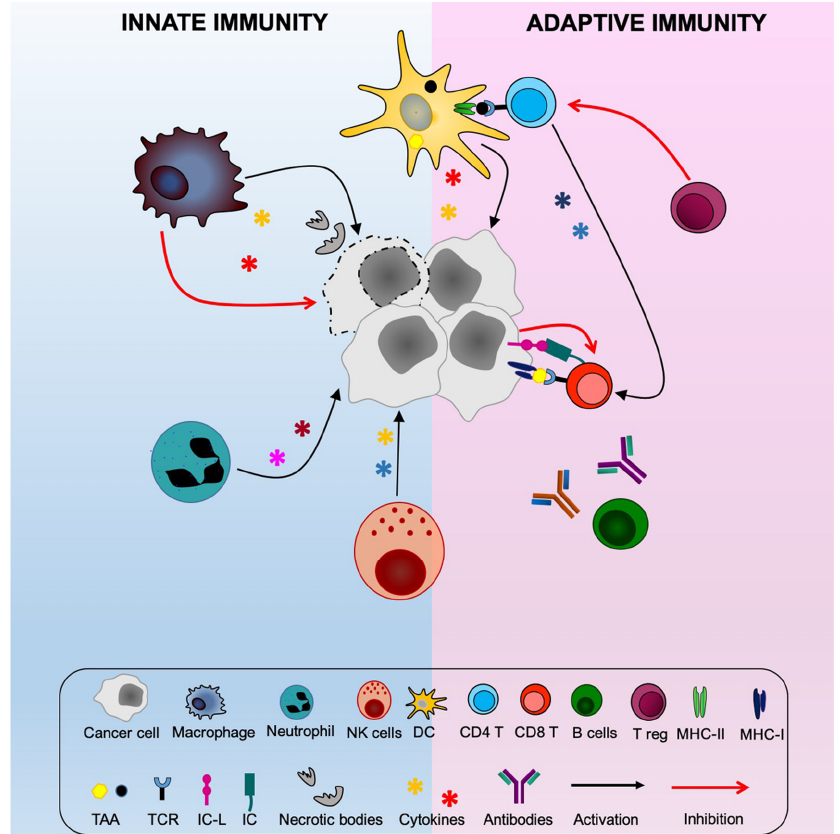
Figure A1. The basic elements of anti-tumor immunity. Cells of the innate immunity such as macrophages and neutrophils, attracted at the tumor site, participate to the destruction and engulphment of the tumor cells via secretion of several products such as inflammatory cytokines (black arrows). Tumor cells may polarize the phenotype of macrophages toward a pro-tumor phenotype (red arrows) by modifying their production of inflammatory cytokines in anti-inflammatory cytokines. At the edge of innate and adaptive immunity, NK cells participate to the host immune response by killing tumor cells that have lost MHC class I expression to elude adaptive CTL immunity. Dendritic cells engulphing necrotic tumor cell debris process and present tumor antigens via their MHC class II molecules to CD4 + Th cells which then trigger the e ff ector mechanisms of anti-tumor immunity, such as antibody producing B cells and particularly CD8 + CTL (black arrows), by secreting specific cytokines. CD4 + Th activity can be blocked by regulatory T cells (Treg), thus hampering the activation of downstream CTL. Moreover, tumor cells can directly block the action of CTL by expressing immune checkpoints ligands (IC-L), such as PD-L1, via interaction with PD-1 (IC) expressed on